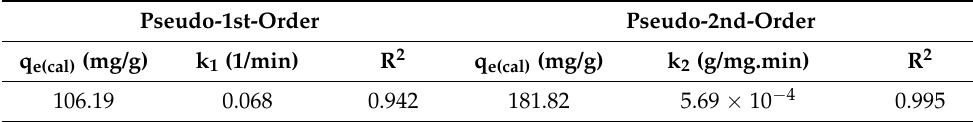
Table 2. For U(VI) adsorption Kinetic parameters of SiO 2 /CS.